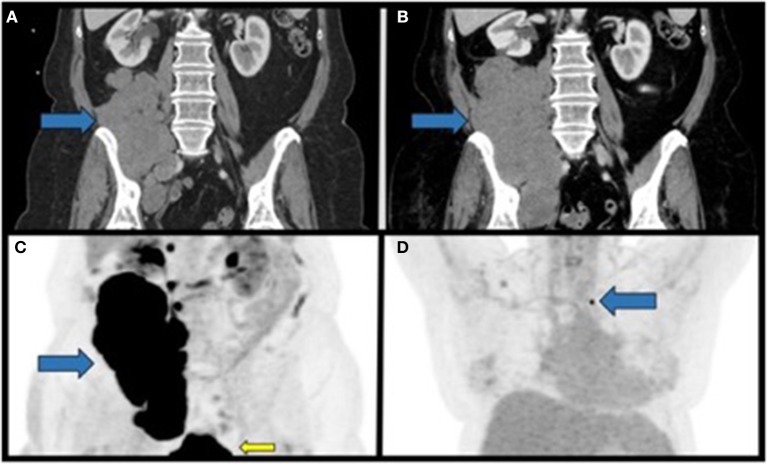
Staging CT scans and PET imaging of the primary tumor and metastatic lesion prior to radiation therapy. (A) Coronal section of the initial CT of the abdomen/pelvis with contrast identifying a large soft-tissue mass in the right retroperitoneal space overlying the right psoas muscle with extension into the right hemi-pelvis. (B) Coronal section of a CT of the abdomen/pelvis approximately 2 months after the initial diagnosis demonstrating interval growth of the now inoperable retroperitoneal mass. (C) Coronal PET/CT maximum intensity projection (MIP) performed approximately 3 months after initial diagnosis, demonstrating the large FDG-avid mass in the right retroperitoneal space (blue arrow). FDG-avidity in the inferior aspect of the image in the figure corresponds to physiological uptake in the urinary bladder (yellow arrow). (D) Coronal PET/CT MIP from the same study as in C demonstrating a non-enlarged FDG-avid lymph node in the left supraclavicular nodal station. Blue arrows, primary mass; yellow arrow, physiologic FDG uptake.